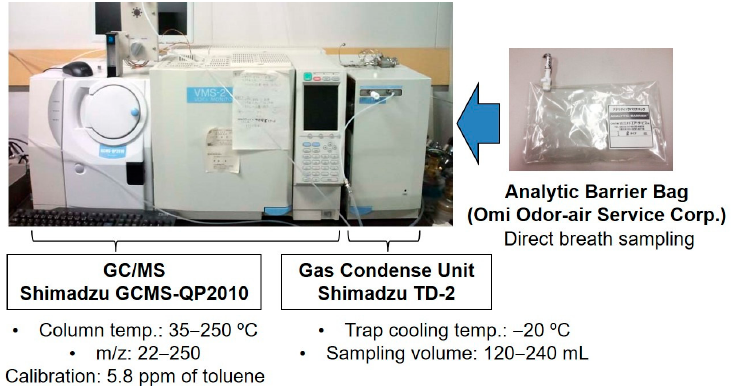
Figure 1. Breath sampling and gas analysis by GC/MS.